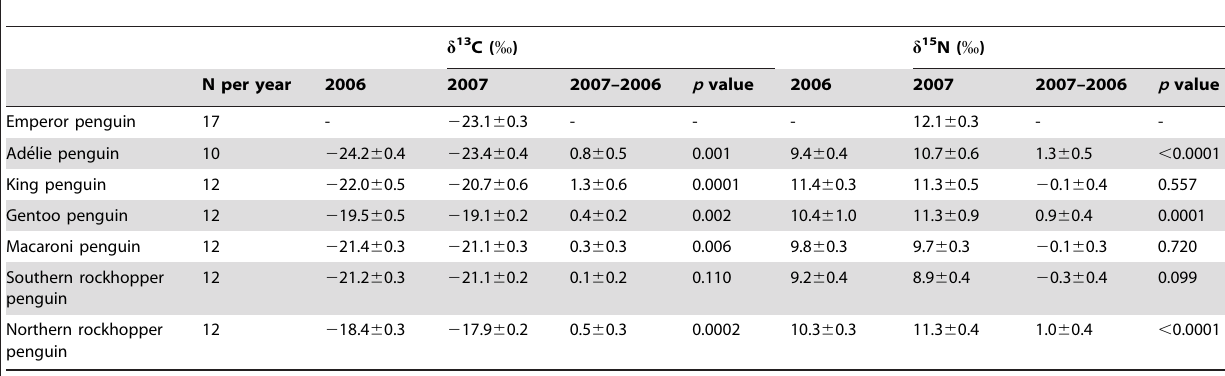
Values are mean 6 SD. P values correspond to paired t- tests performed between the two years. Carbon isotopic values were not corrected for Suess and increase [CO